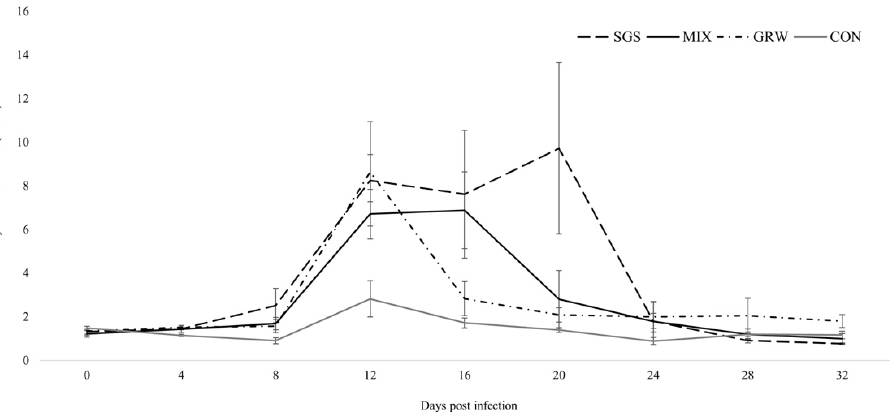
Figure 4. Percentage of polychromatic (i.e., young) red blood cells in experimentally infected and control birds. Symbols are as in Figure 2.